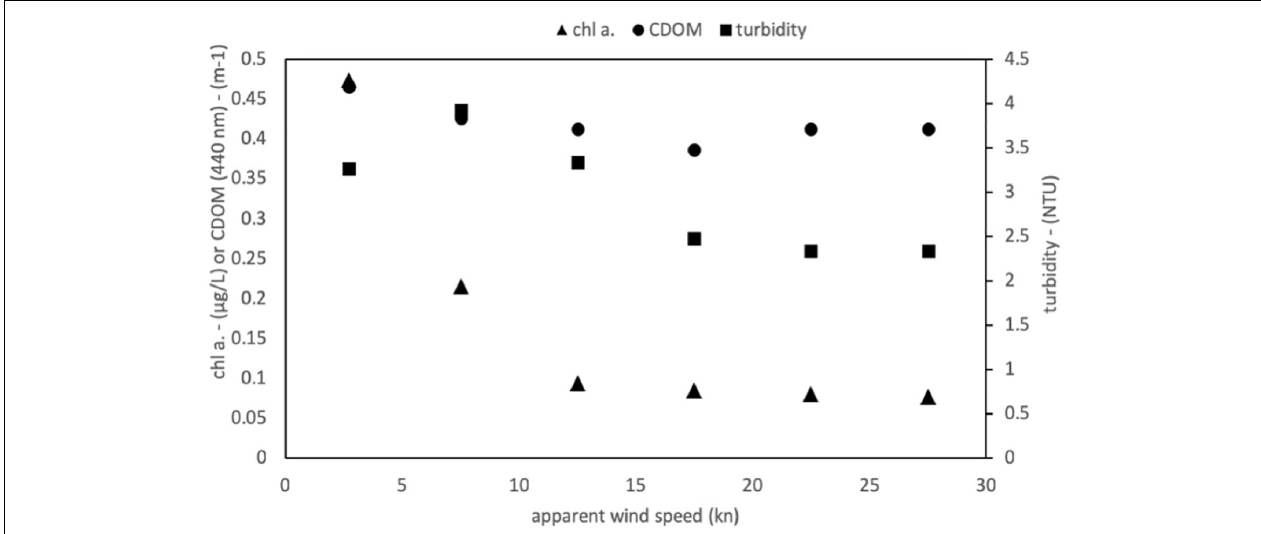
FIGURE 5 | For all deployments, the fluorometer data were binned by their associated 5-knot interval apparent winds speeds to determine if wind and associated bubbles exhibited an artifact.